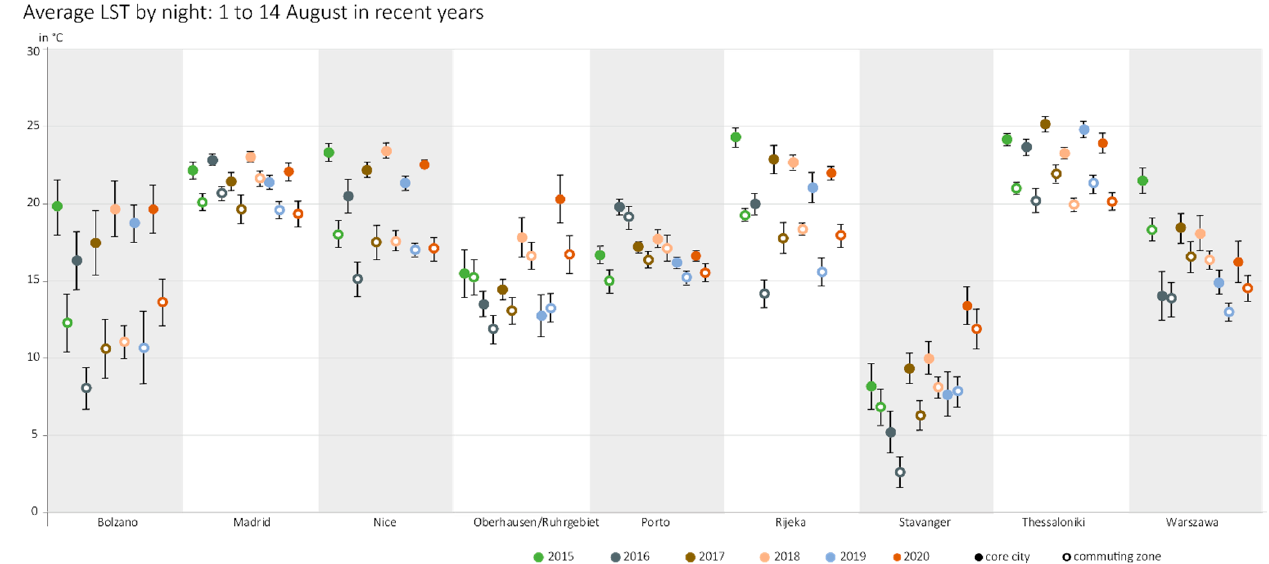
Figure 7. Average LST by night: 1 to 14 August in selected FUAs in recent years.